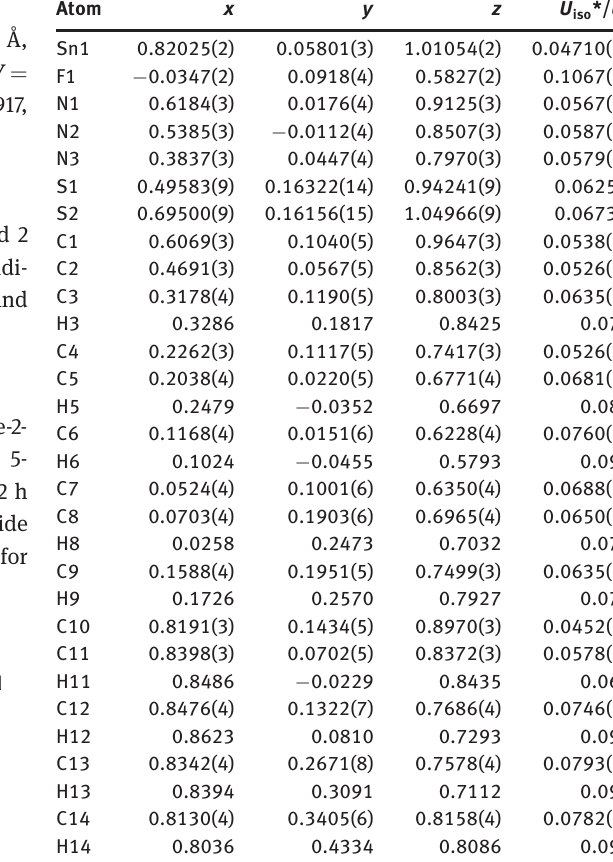
Table 2: Fractional atomic coordinates and isotropic or equivalent isotropic displacement parameters (Å 2